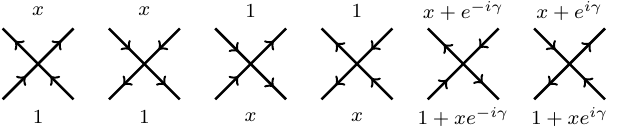
Figure 3 . The vertices and their Boltzmann weights, shown below (resp. above) the vertex for a tile corresponding to a horizontal (resp. vertical) pair of Potts